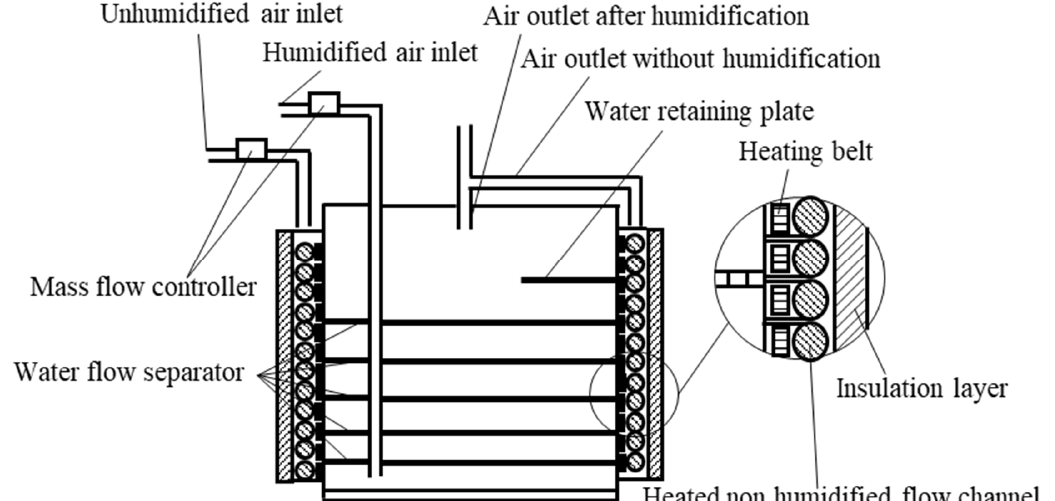
Figure 3. Section view of the humidifier.